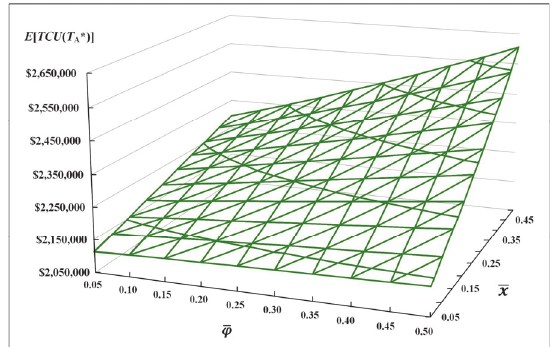
Fig. 11. The collective influence of changes in average defective and scrap rates on E [ TCU ( T A *)]